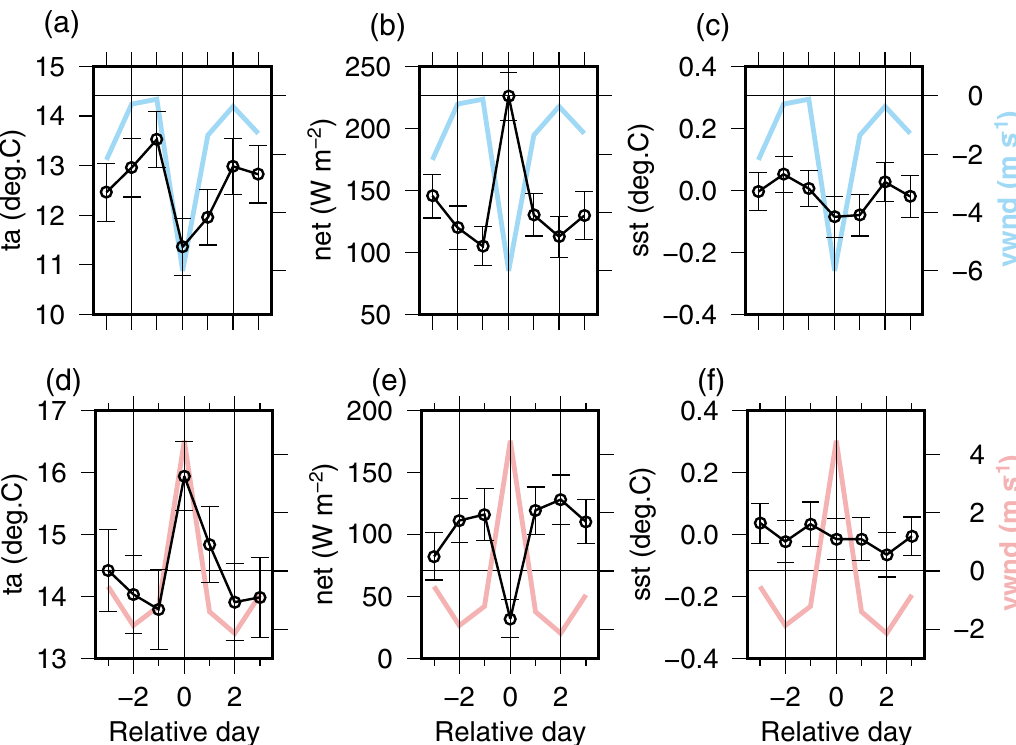
Figure 3. Northerly ( a – c ) and southerly ( d – f ) wind composite time series at JKEO: ( a , d ) surface air temperature (ta), ( b , e ) surface net heat flux, ( c , f ) high-pass filtered sea surface temperature (sst). A second order Butterworth high-pass filter was used in this analysis. The horizonal axis indicates the relative day from the peak (0). The error bars indicate standard error. The red and blue lines indicate the meridional component of surface winds (vwnd) for northerly and southerly wind events, respectively. The figures for other components of flux and related variables are shown in Supplementary Figs. S4 and